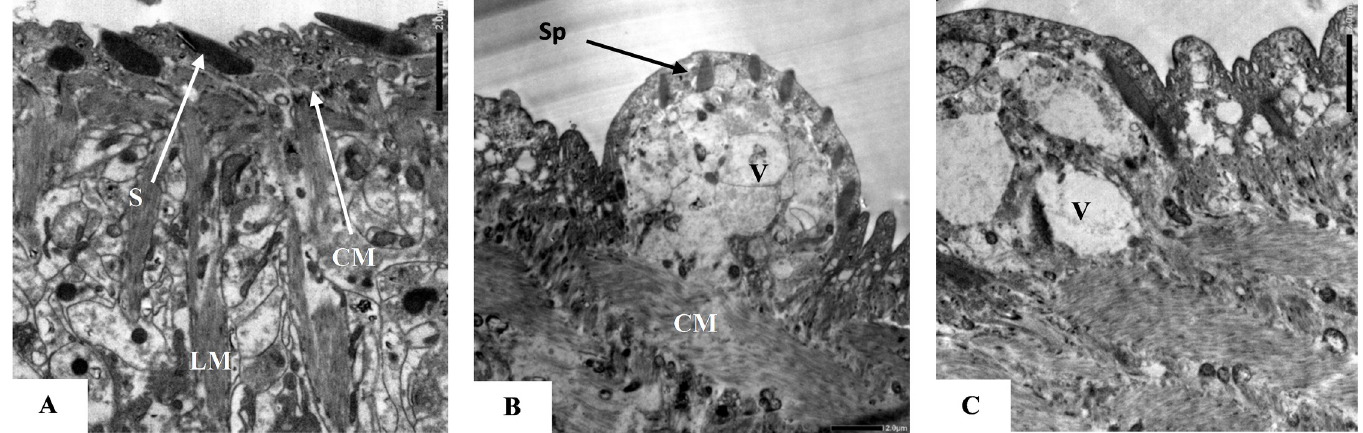
Fig 5. TEM of adult male tegument in infected control group (A), infected vaccinated group (B) and infected vaccinated adjuvanted group (C). (A) Normal outer tegumental layer showing large triangular spines (S), circular muscles (CM), and longitudinal muscles (LM) (X3000). (B) Blebbing of the tegument with deeply sunken spines (Sp), the subtegumental tissue shows vacuolation (V) with disruption of the circular muscles (Cm) (X 2000). (C) Irregularity of the tegument with absence of the spine, the subsegmental tissue shows vacuolation (V) with disruption of the circular muscle (X